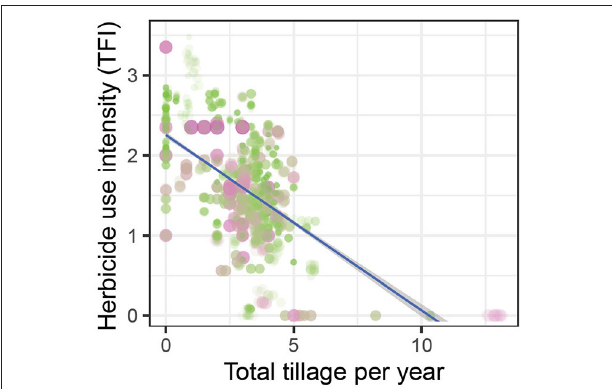
FIGURE 1 | Herbicide use intensity vs. tillage intensity in the 395 recorded cropping systems (the blue line shows the fitted regression y = 2.24–0.217 x, with the confidence interval in gray). The color and size of the data points illustrate the simulated grain yield loss averaged over 30 simulated years, ranging from zero loss (green, smallest symbol) to total loss (magenta, largest symbol). Symbols are partially transparent to take account of overlaying. HTFI, herbicide treatment frequency index (unitless), i.e., average number of doses at the recommended dose per ha per year ( Colbach, 2022